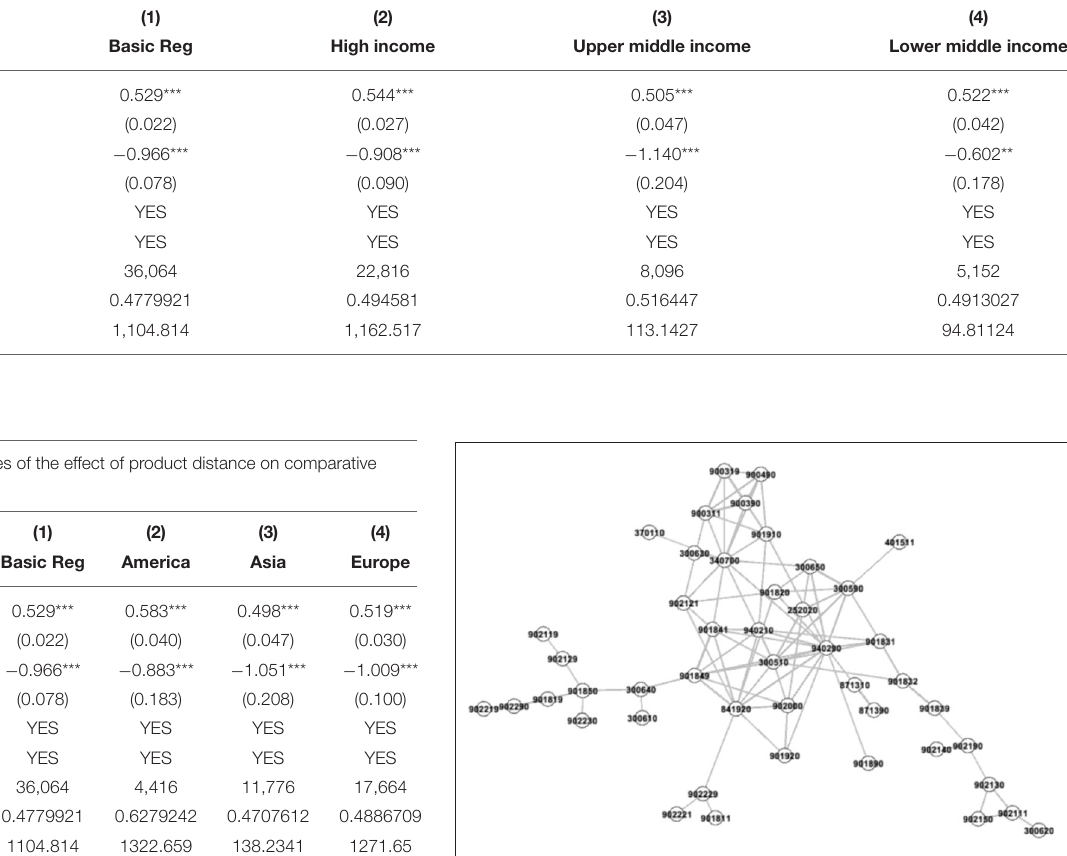
FIGURE 1 | Medical device product